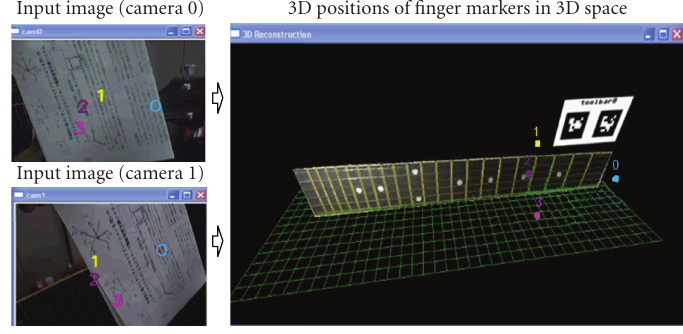
Figure 4: Representative snapshots from the online tracking experiment.